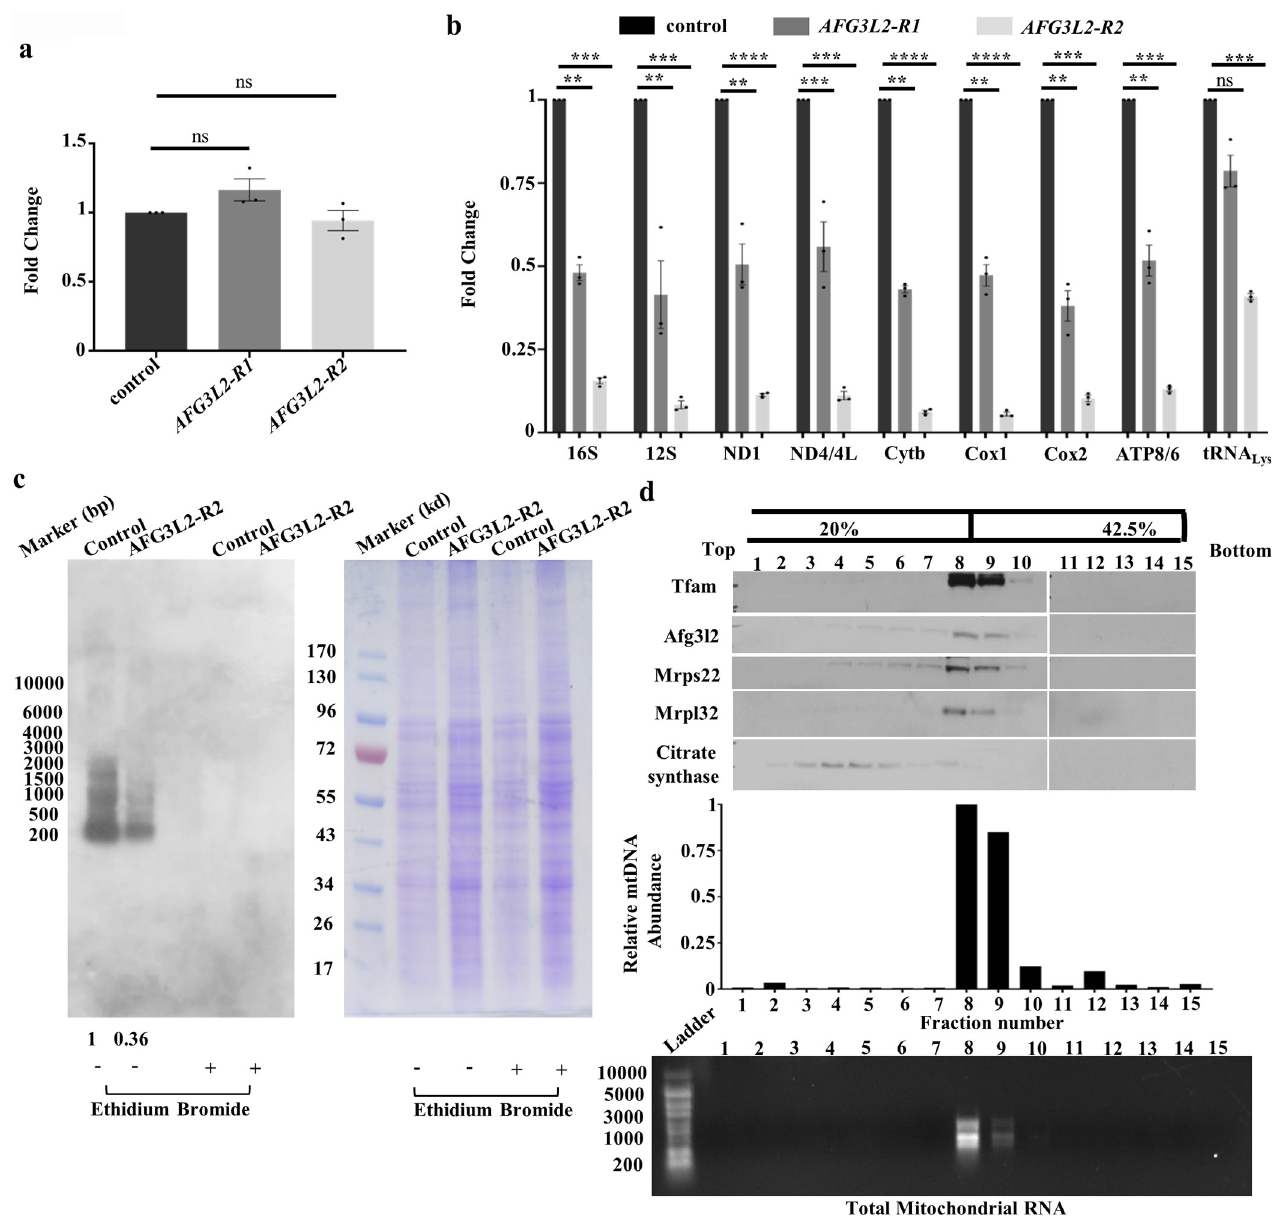
Fig 6. Afg3l2 deficiency impairs mitochondrial transcription. a. mtDNA abundance was compared in control (UAS- LUCIFERASE RNAi/da-Gal4) and AFG3L2 -deficient (UAS- AFG3L2-R1 RNAi; da-Gal4 and UAS- AFG3L2-R2 RNAi/da-Gal4) pupae using RT-PCR (N = 3 independent groups of 5 pupae). Statistical significance was determined by one way ANOVA Tukey’s test for multiple comparison. b. Quantification of mitochondrial RNA levels in control (UAS- LUCIFERASE RNAi/da-Gal4) and AFG3L2 -deficient (UAS- AFG3L2-R1 RNAi; da-Gal4 and UAS- AFG3L2-R2 RNAi/da-Gal4) pupae using qRT-PCR (N = 3 independent groups of 5 pupae, �� p < 0.005, ��� p < 0.0005, ���� p < 0.0001 by one way ANOVA Tukey’s test for multiple comparison). c. In organello transcription analysis using mitochondria from control (UAS- LUCIFERASE RNAi/da-Gal4) and AFG3L2 -deficient (UAS- AFG3L2-R2 RNAi/da-Gal4) pupae in the presence and absence of ethidium bromide, a specific inhibitor of mitochondrial transcription. The right panel shows a Coomassie-stained gel from the same mitochondrial preparations to normalize protein loading (control samples defined as 1.0). d. Mitochondrial protein extracts isolated from control (UAS- LUCIFERASE RNAi/da-Gal4) pupae were subjected to iodixanol density gradient analysis. Fractions from the gradient were subjected to western blot analysis (top panel) using the indicated antisera (top panel), qPCR to quantify mtDNA abundance (middle panel), or denaturing agarose gel electrophoresis to identify mitochondrial RNA-containing fractions (bottom